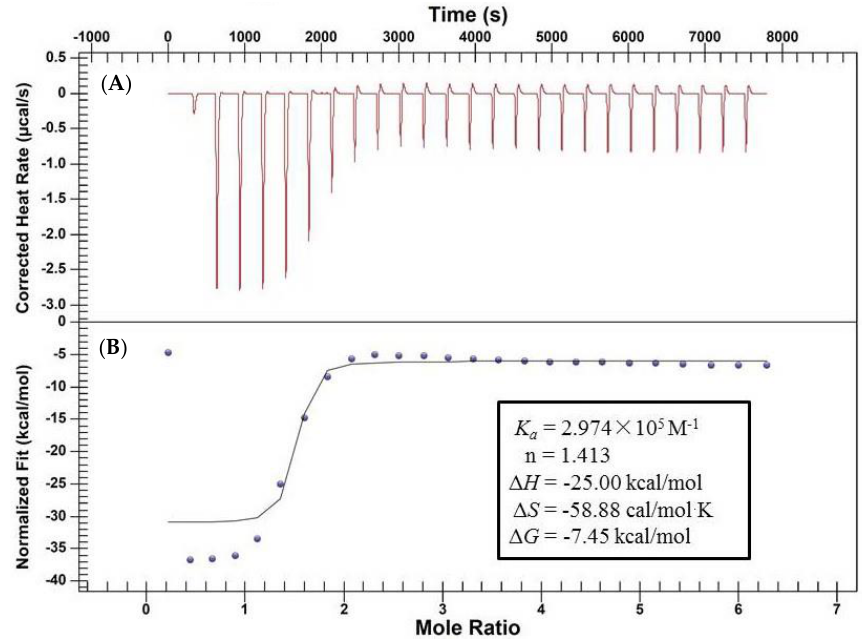
Figure 6. Calorimetric titration of the H subunit of V-ATPase with JW-3 at 298 K. ( A ) Heat flow as a function of time; ( B ) Reaction enthalpy of JW-3 versus injection number. The solid line corresponds to the theoretical independent model. The thermodynamic constants are presented in the pane.